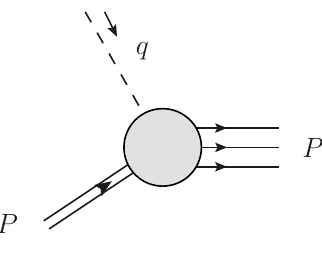
Figure 5 . DIS process mediated by a scalar boson, as in